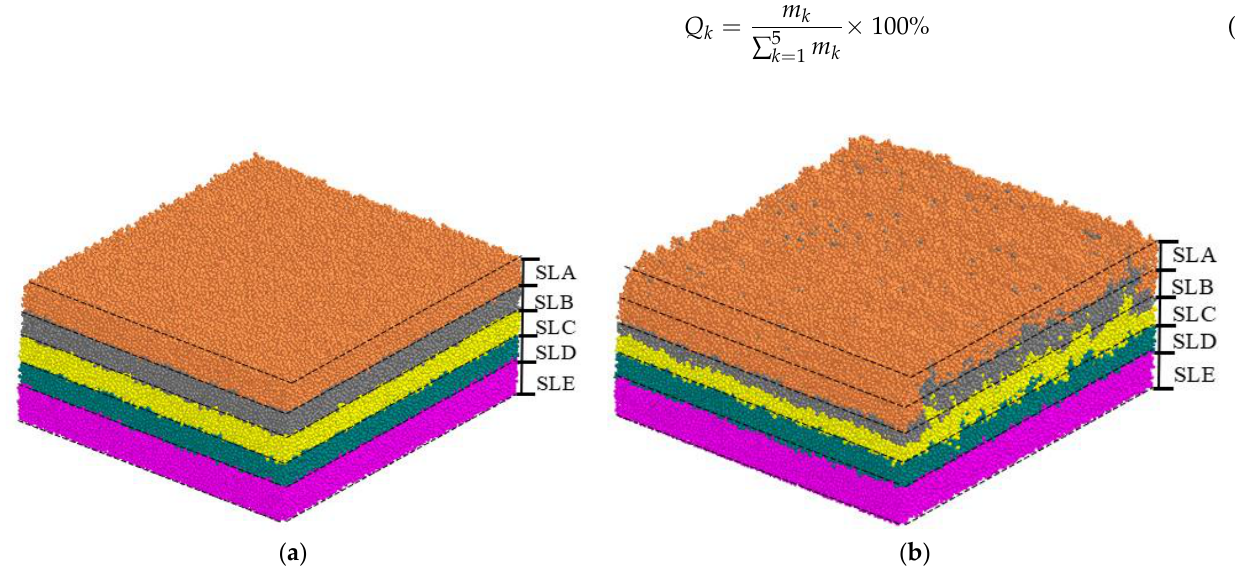
Figure 7. Soil disturbance and particle distribution of soil in different layers: ( a ) Before harvesting; ( b ) After harvesting.